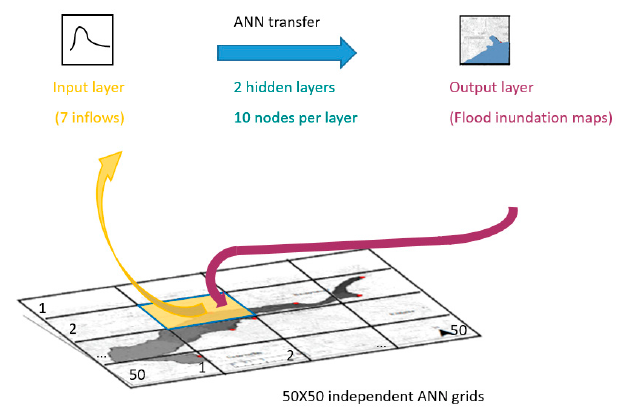
Figure 1. The forward-feed neural network setup in the forecast study. The input layer is fed with discharge inflows of certain time interval windows. The output layer generates the flood inundation for that interval. Resilient backpropagation is applied for training this network.